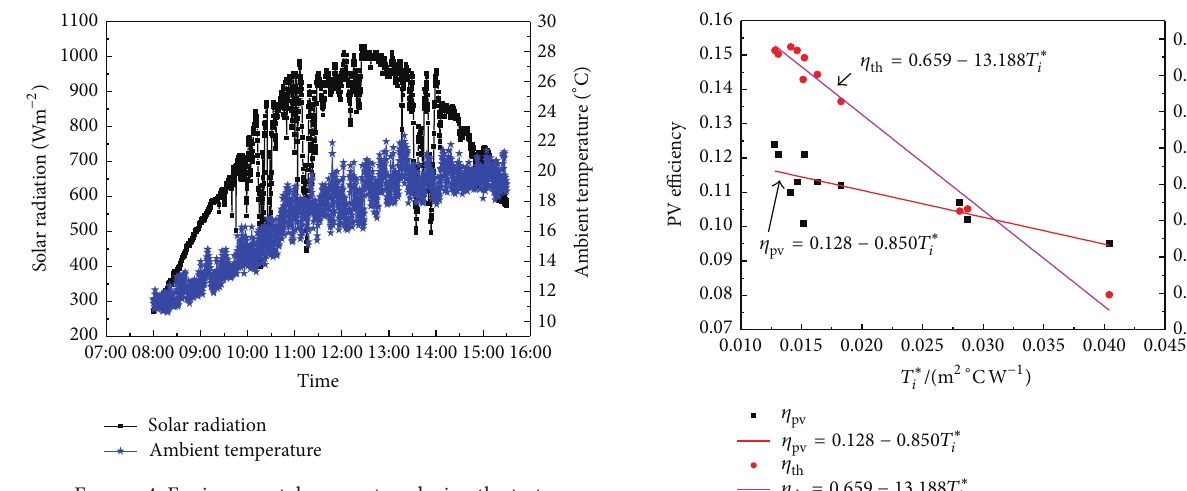
Figure 4: Environmental parameters during the test.